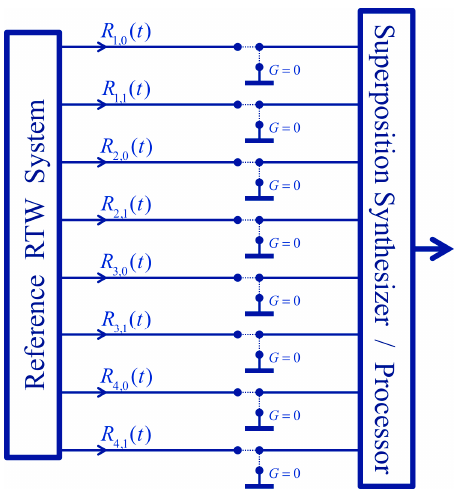
Figure 7. INBL generic hardware scheme with two-state switches in the reference wires to provide the opportunity of grounding (that is, forcing zero onto) selected reference wires.